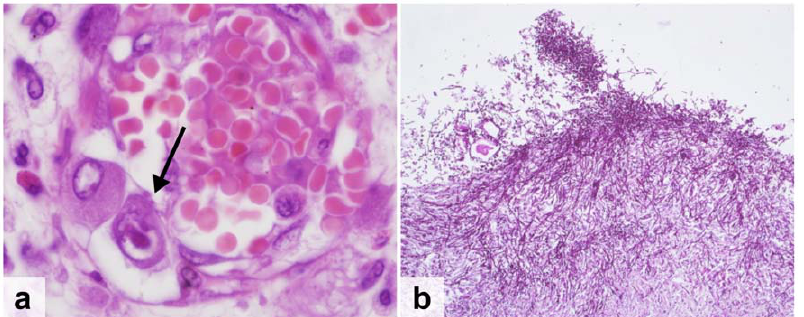
Figure 4. Opportunistic infections. a. Cytomegalovirus infection showing an ‘‘owl-eye’’ nuclear inclusion in an endothelial cell (H&E stain, arrow) b. Esophageal candidiasis showing yeast and pseudohyphae (PAS stain).